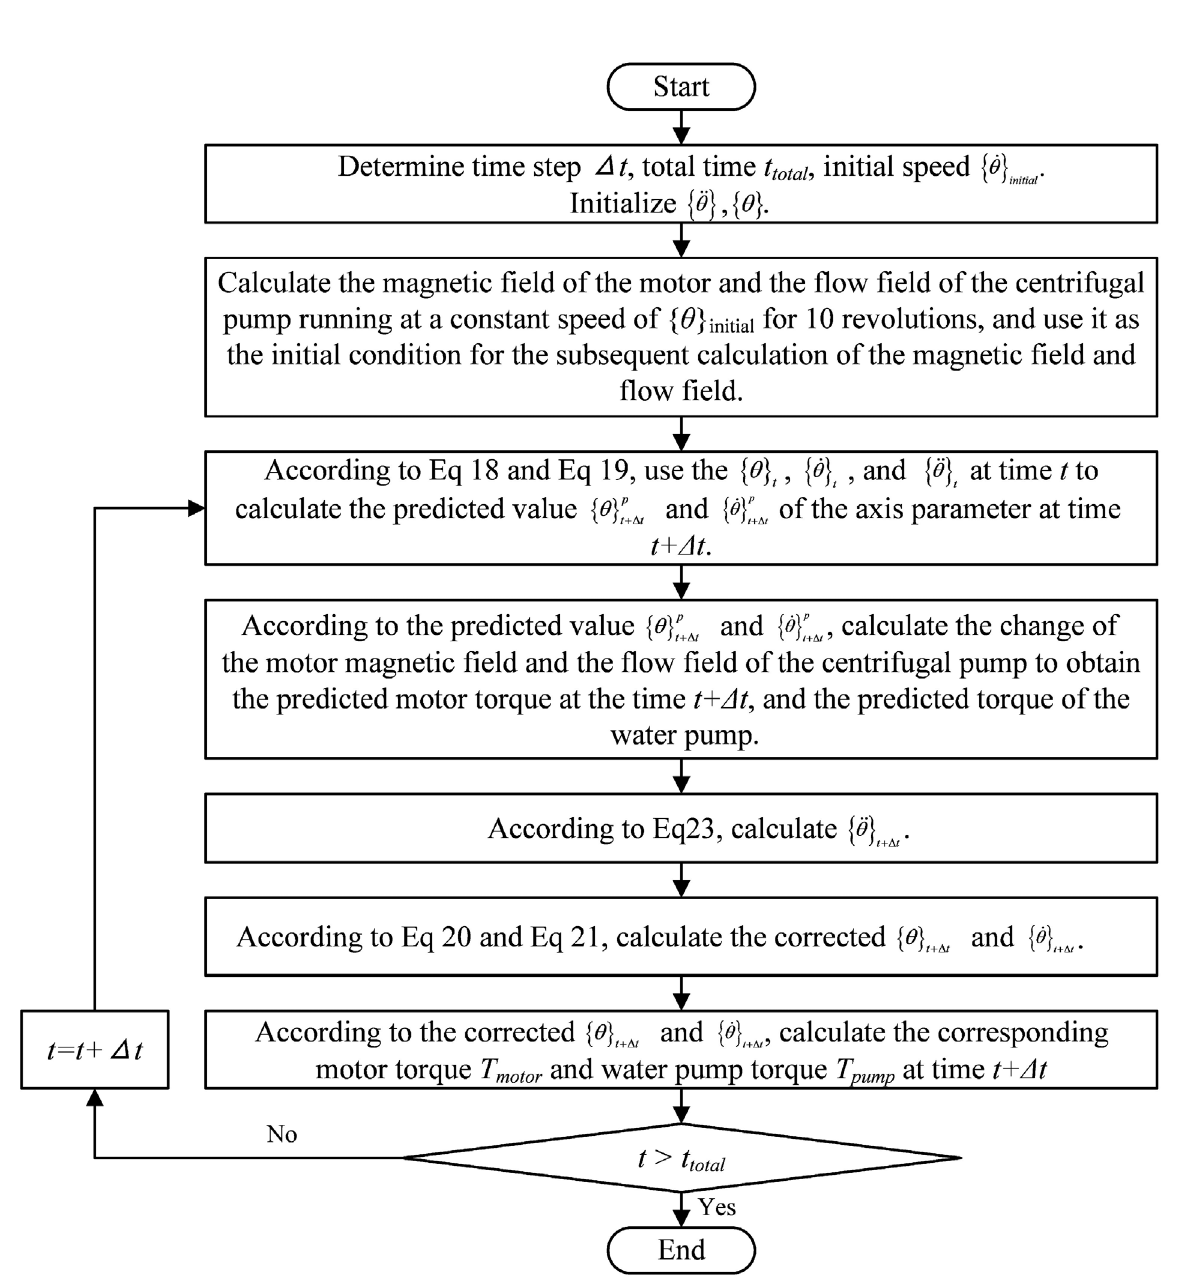
Fig. 12. Flow chart of coupling calculation of centrifugal pump